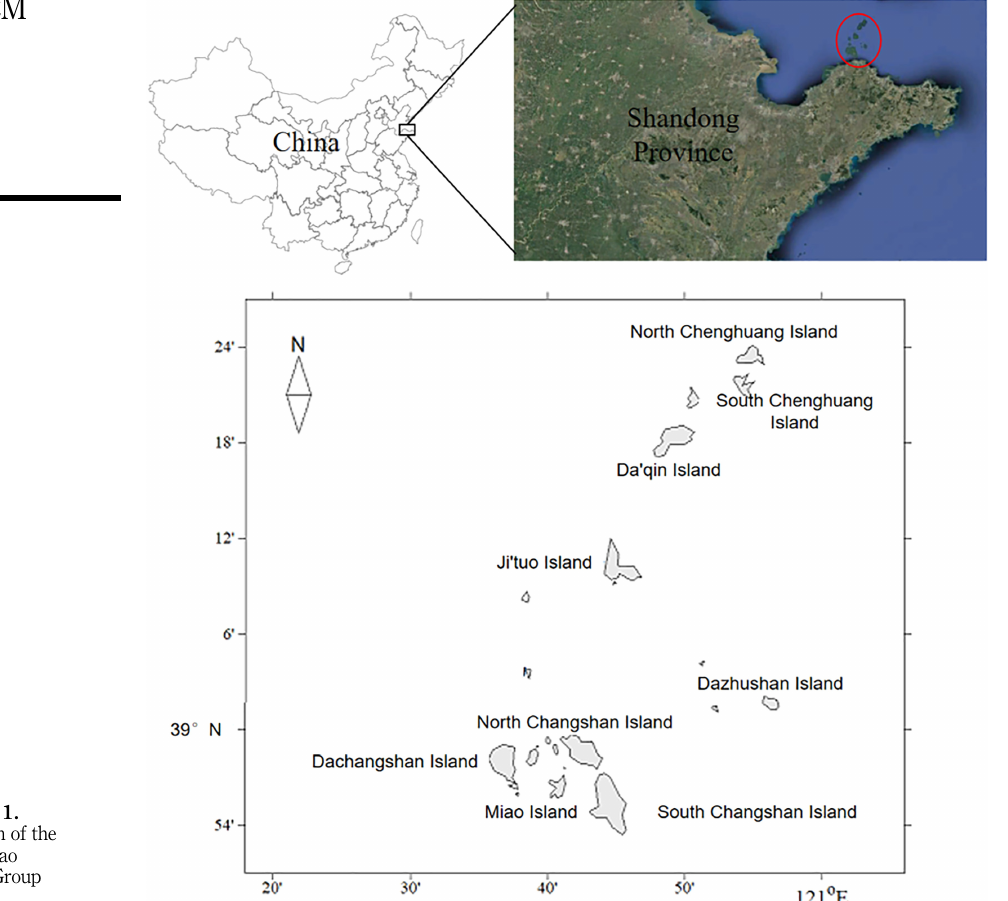
Figure 1. Location of the Changdao Island